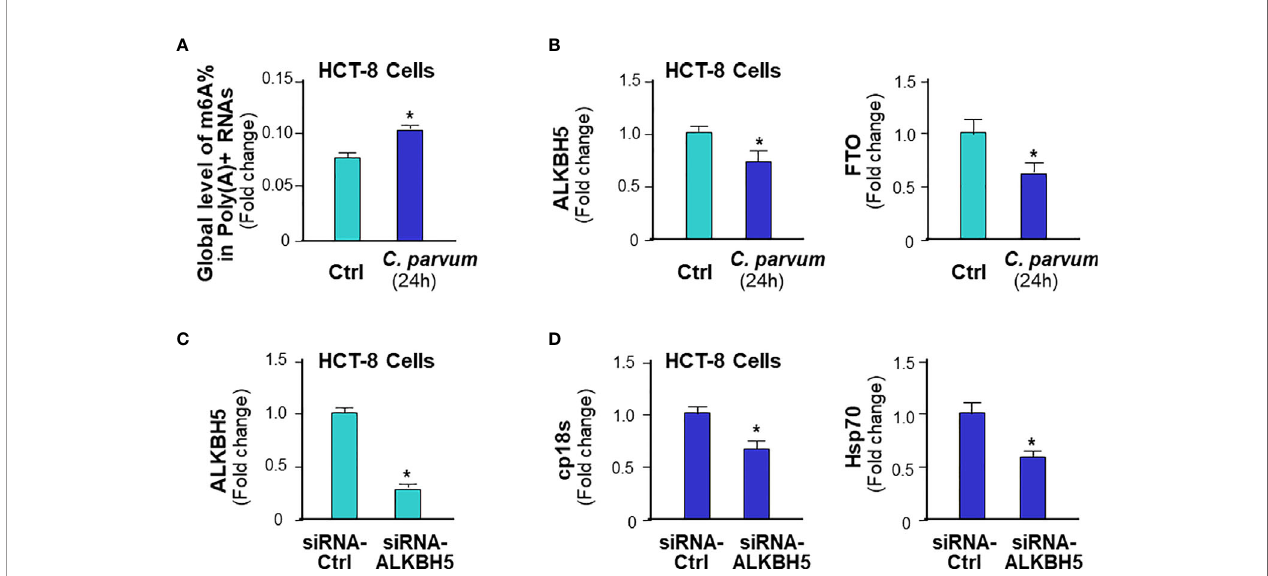
FIGURE 8 | m 6 A methylation-mediated intestinal epithelial anti- C. parvum defense in human intestinal epithelium. (A) Increase of global m 6 A RNA methylation in HCT-8 cells following C. parvum infection. Cells were exposed to C. parvum infection for 24h and m 6 A RNA methylation was measured by m 6 A RNA methylation quantitation assay. (B) Decrease of ALKBH5 and FTO expression levels in HCT-8 cells following C. parvum infection. Cells were exposed to C. parvum infection for 24h and expression levels of ALKBH5 and FTO was measured by real-time PCR. (C) Knockdown of ALKBH5 via siRNA in HCT-8 cells. Cells were treated with the siRNA to ALKBH5 for 24h and knockdown of ALKBH5 was con fi rmed by real-time PCR. Cells transfected with non-speci fi c control siRNA were used as the control. (D) Knockdown ALKBH5 in HCT-8 cells decreased C. parvum infection burden. HCT-8 cells were fi rst treated with the siRNA-ALKBH5 and then exposed to C. parvum infection for 24h. Infection burden of C. parvum was quanti fi ed by measuring parasite cpHsp70 or cp18s using real-time PCR. Data represent three independent experiments. *p<.05 vs the non-infected control (in A – D